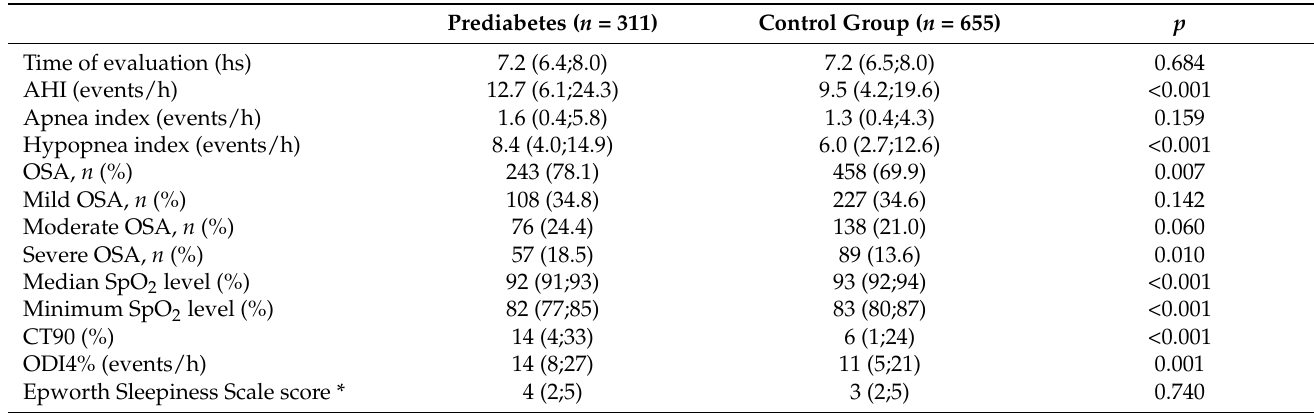
Table 2. Nighttime respiratory characteristics of the study population according to the presence of prediabetes.